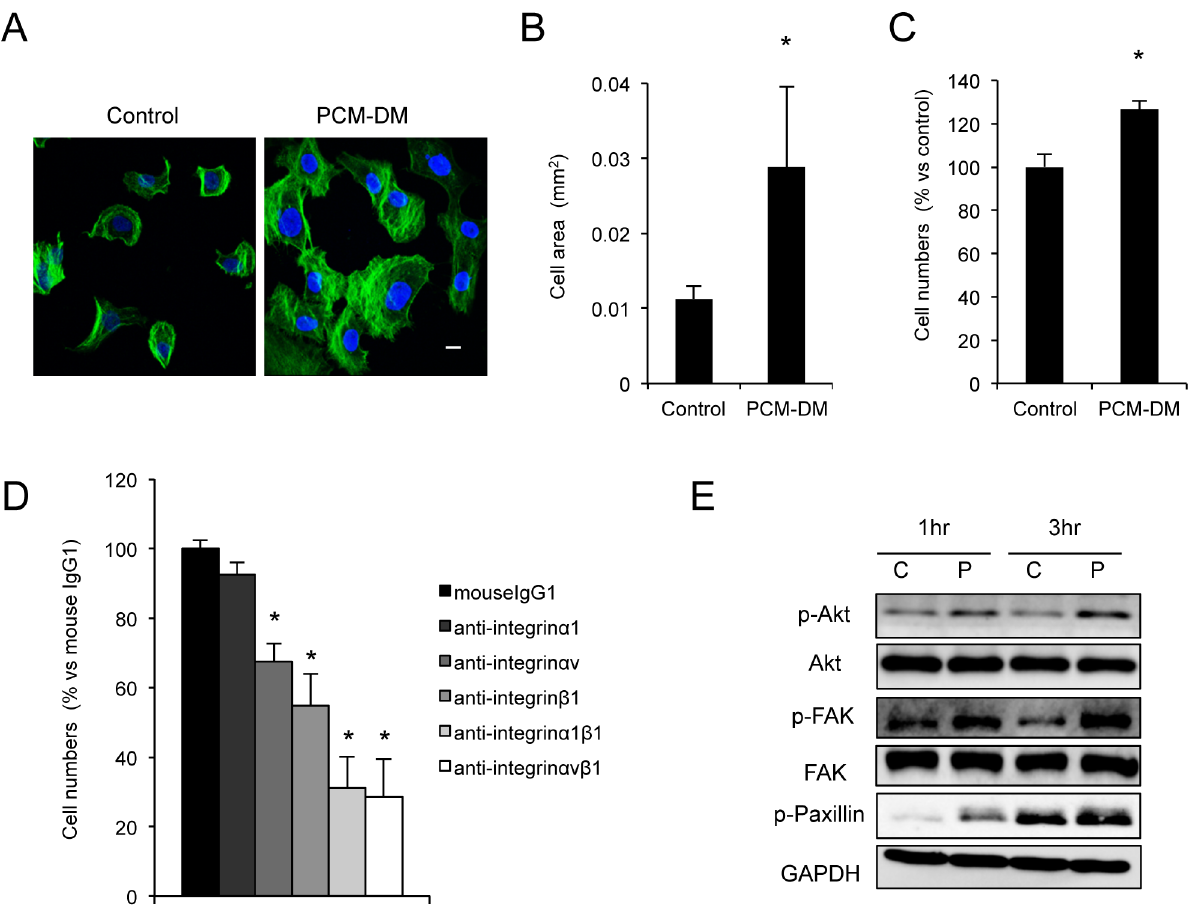
Figure 2. Effect of PCM-DM on cell adhesion. (A + B) Monkey CECs (MCECs) were seeded at a density of 2.5 6 10 3 cells/well, and their cell morphology was evaluated by actin immunostaining after 24 h. The cell area was measured by Image J software (National Institutes of Health), and the mean cell area was plotted ( n =10). The pictures are representative of two independent experiments * p , 0.01; scale bar, 100 m m. (C) The MCECs were seeded at a density of 5.0 6 10 3 cells/well, and the number of adhered MCECs was examined with a CellTiter-Glo TM luminescent cell viability assay after 1 h. The experiments were performed in triplicate. * p , 0.01. (D) The MCECs were seeded at a density of 1.0 6 10 4 cells/well and incubated with DMEM supplemented with 10% FBS with 2 m g/mL neutralizing antibodies ( a 1, a v, and/or b 1 integrin subunits). The number of adhered MCECs was examined with a CellTiter-Glo TM luminescent cell viability assay after 3 h. The experiments were performed in triplicate. * p , 0.01. (E) MCECs seeded on the PCM-DM or the control culture dish for 1 or 3 h. Phosphorylation of Akt, FAK, and paxillin was evaluated by Western blot analysis. The experiments were performed in duplicate.